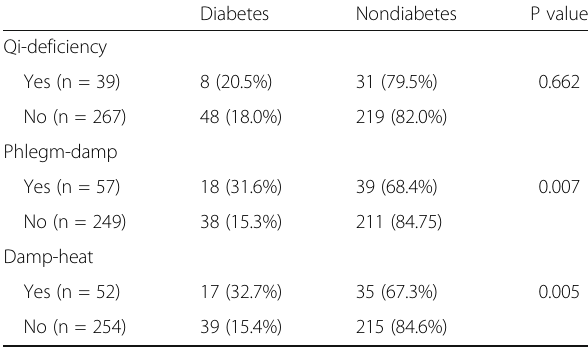
Table 2 Incidence of diabetes in IGR patients according to BC Diabetes Nondiabetes